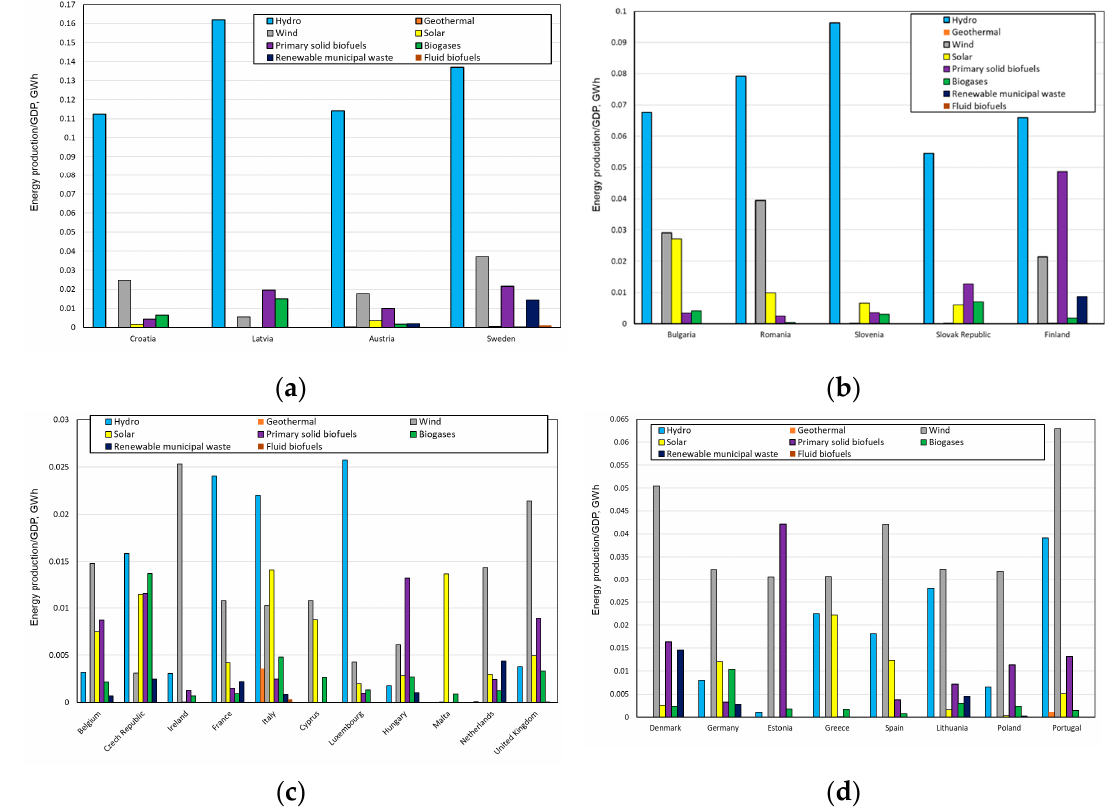
Figure 12. Structure and volume of energy production from renewable energy sources in relation to the value of GDP by countries in individual clusters; cluster 1 ( a ); cluster 2 ( b ); cluster 3 ( c ); cluster 4 ( d ) (own study).